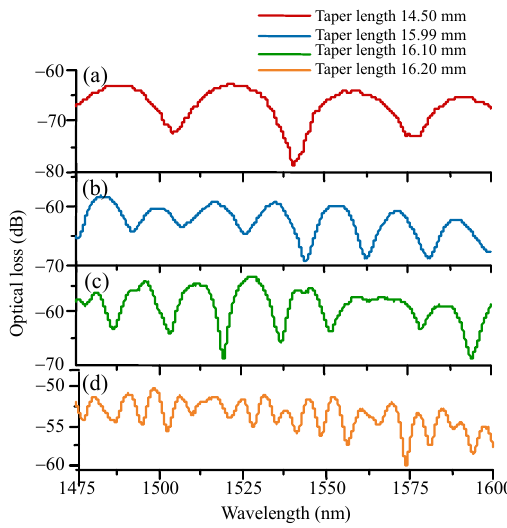
Fig. 9 Spectrogram of sensors with different taper lengths: (a) sensor with a taper length of 14.50 mm, (b) sensor with a taper length of 15.99 mm, (c) sensor with a taper length of 16.10 mm, and (d) sensor with a taper length of 16.20